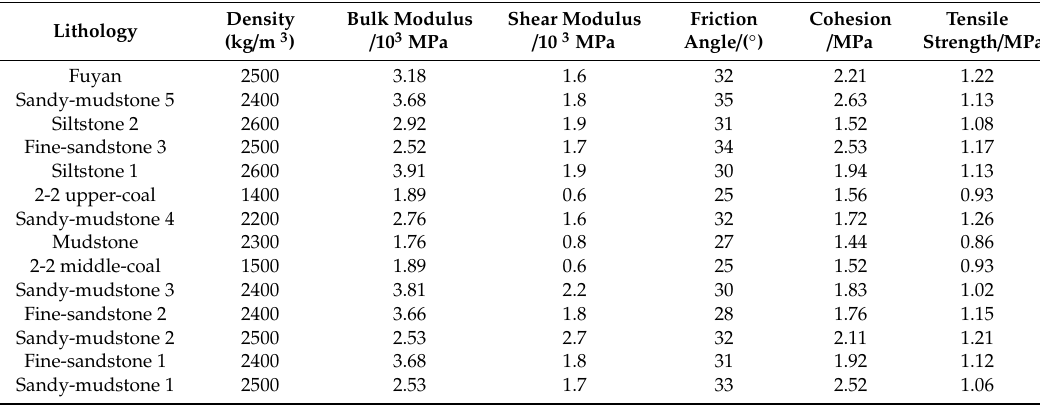
Figure 5. Borehole imaging screenshot. Table 1. Lithology and rock mechanics parameters.